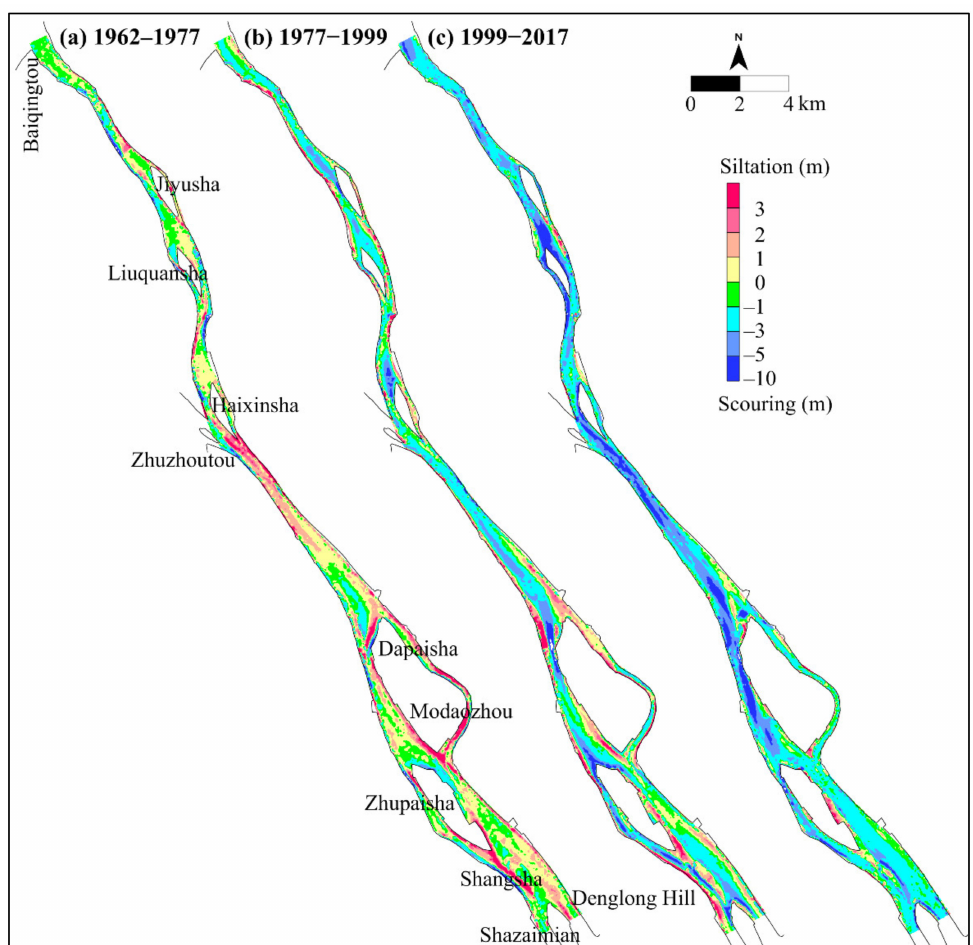
Figure 5. Maps of scouring and siltation along the channel during different decades. ( a )